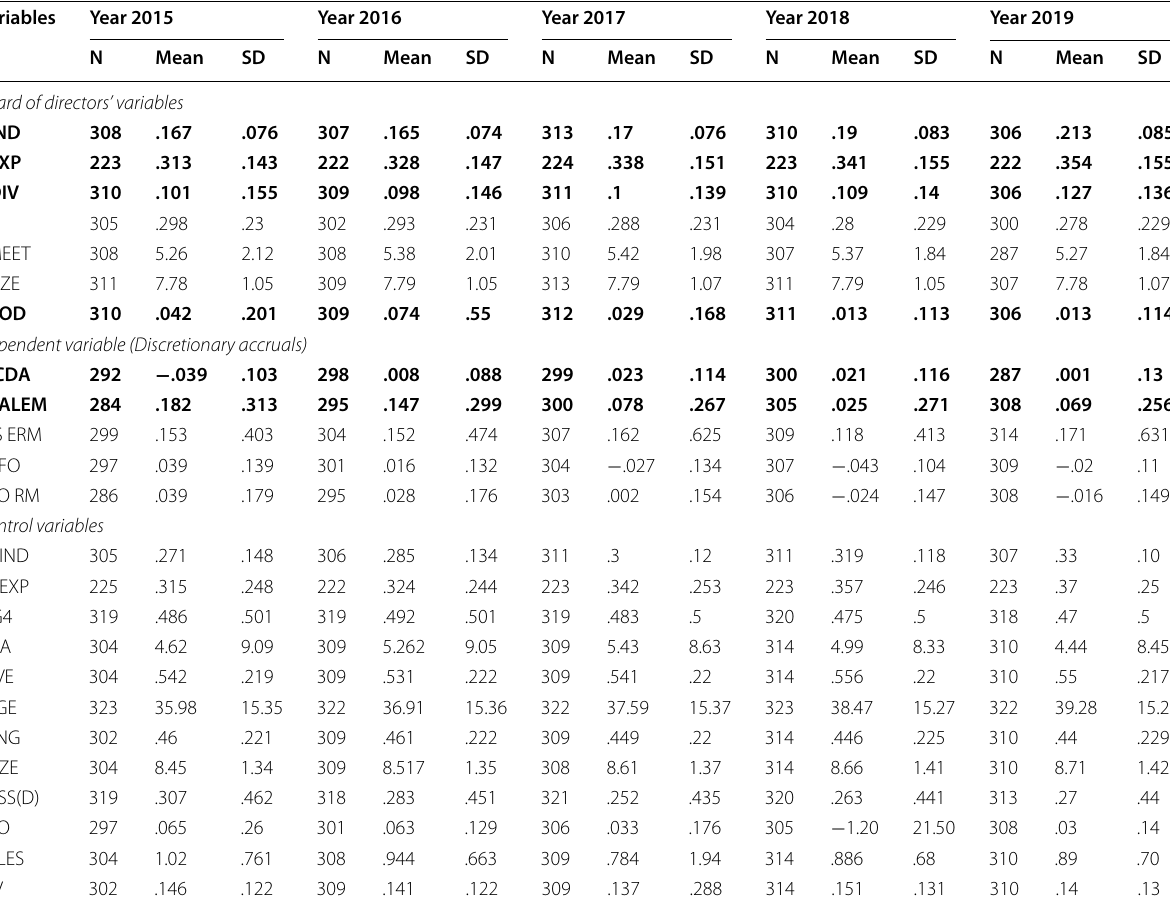
Table 4 Year-wise descriptive statistics of board of directors, and earnings management